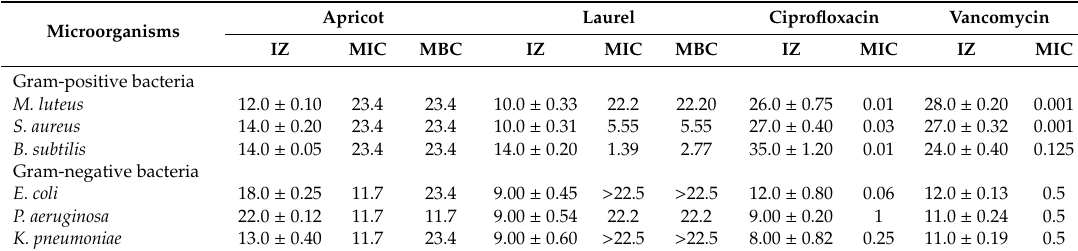
Table 2. Inhibition zone diameters, MIC and MBC of essential oils from apricot ( P. armeniaca ) and laurel ( L. nobilis ) leaves, and antibiotics, against bacteria using the disc di ff usion and micro-well dilution assays. Apricot Laurel Ciprofloxacin Vancomycin Microorganisms IZ MIC MBC IZ MIC MBC IZ MIC IZ MIC Gram-positive bacteria M. luteus